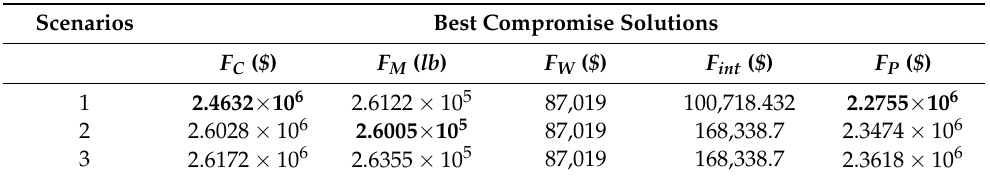
Table 9. The best compromise solutions for different scenarios.